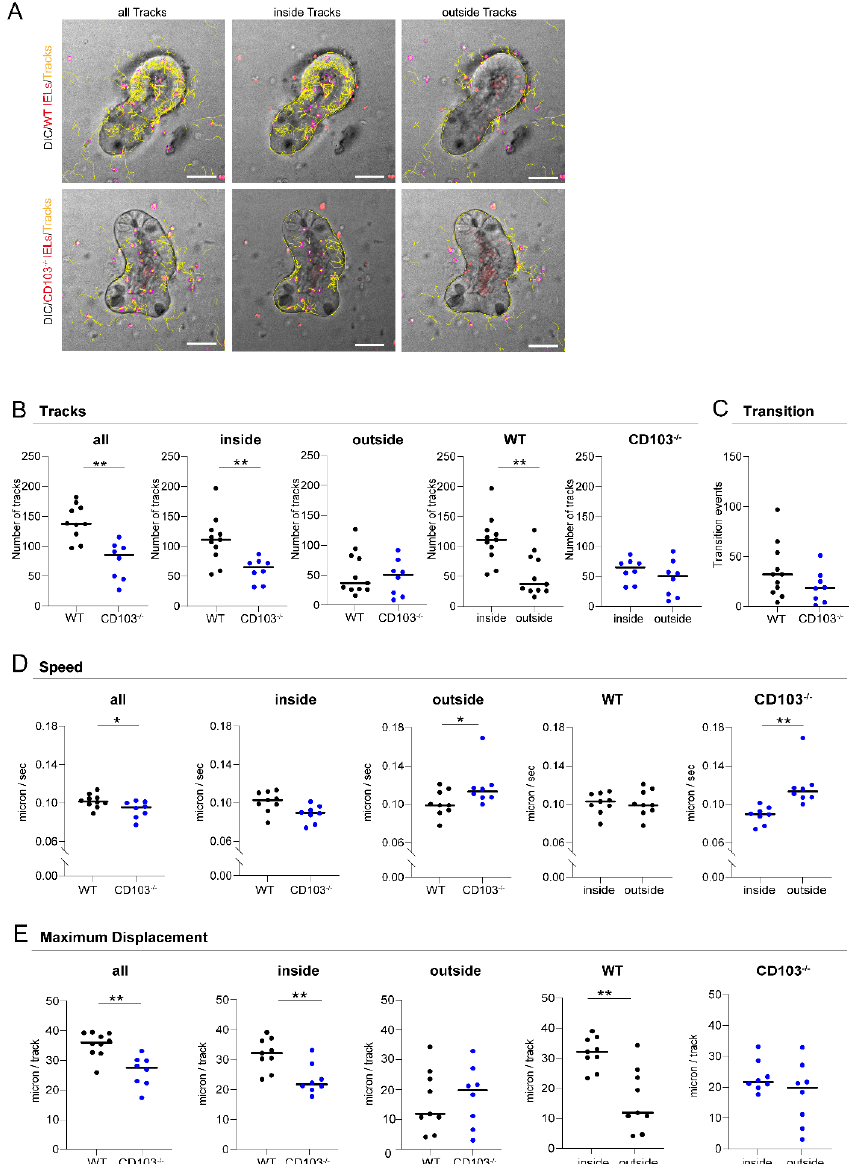
Figure 4. CD103-deficient IELs display aberrant mobility and migration patterns. ( A ) IEL-IEC co-cultures with two days old organoids and fluorescently labeled IELs (Cell Proliferation Dye, red) from wildtype (WT) and CD103 − / − mice (as indicated) were serially studied after overnight incubation by time-lapse imaging using spinning disc microscopy in differential interference contrast (DIC) with an objective lens at 25 × magnification. IEL tracks of the entire area (all tracks, left), within IECs (inside tracks, middle), or around IECs (outside tracks, right) are marked in yellow. Scale bar 50 µ m. ( B ) The number of IEL tracks within the subgroups as specified were quantified in IEL-IEC co-cultures with IELs from wildtype and CD103 − / − mice, respectively. A track is a contiguous, comprehensible movement of one cell over several frames and is represented by a single yellow line (see Section 4.10). ( C ) The number of IEL tracks occurring as transition events, i.e., crossing between inside and outside of IEC organoids, was analyzed in IEL-IEC co-cultures with IELs from wildtype and CD103 − / − mice, respectively. ( D ) The mean speed of cells including within the subgroups as specified was calculated in IEL-IEC co-cultures with IELs from wildtype and CD103 − / − mice, respectively. ( E ) The maximum displacement, i.e., mean of the highest 15 track length values per time-lapse movie, was compared in IEL-IEC co-cultures between IELs from wildtype and CD103 − / − mice, respectively. Please see Section 4. for the definition of terms and more details on methodology. Co-cultures were incubated overnight before imaging. n = 8–10 per group. All data are representative of at least three independent experiments. * p < 0.05, ** p <